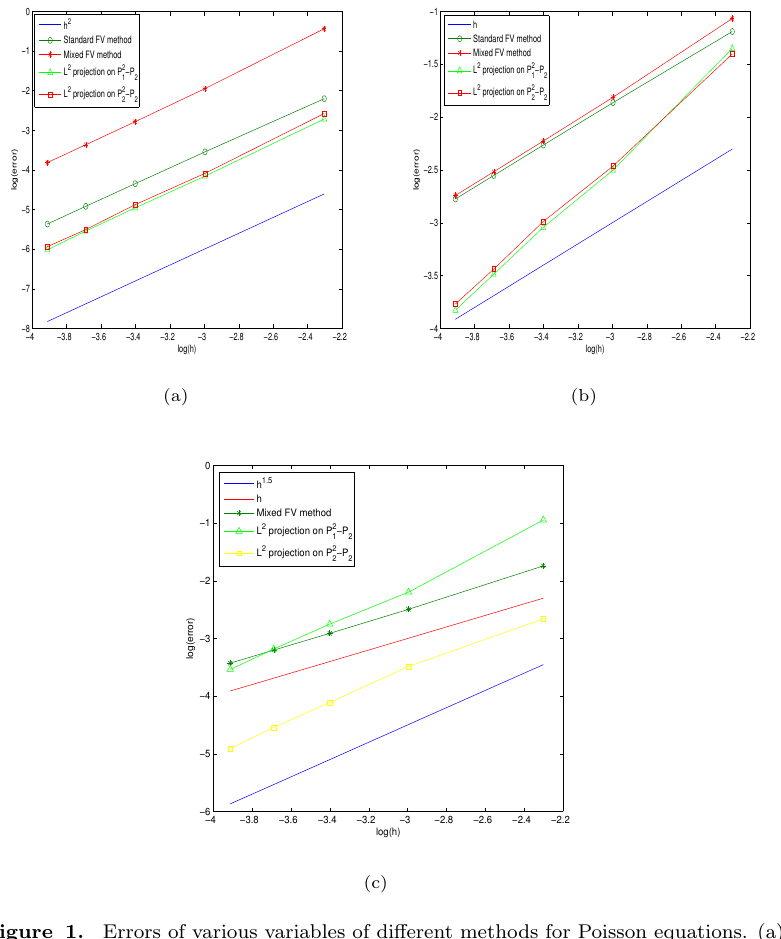
Figure 1. Errors of various variables of different methods for Poisson equations. (a) L 2 -error for pressure, (b) H 1 -error for the pressure, (c) L 2 -error for